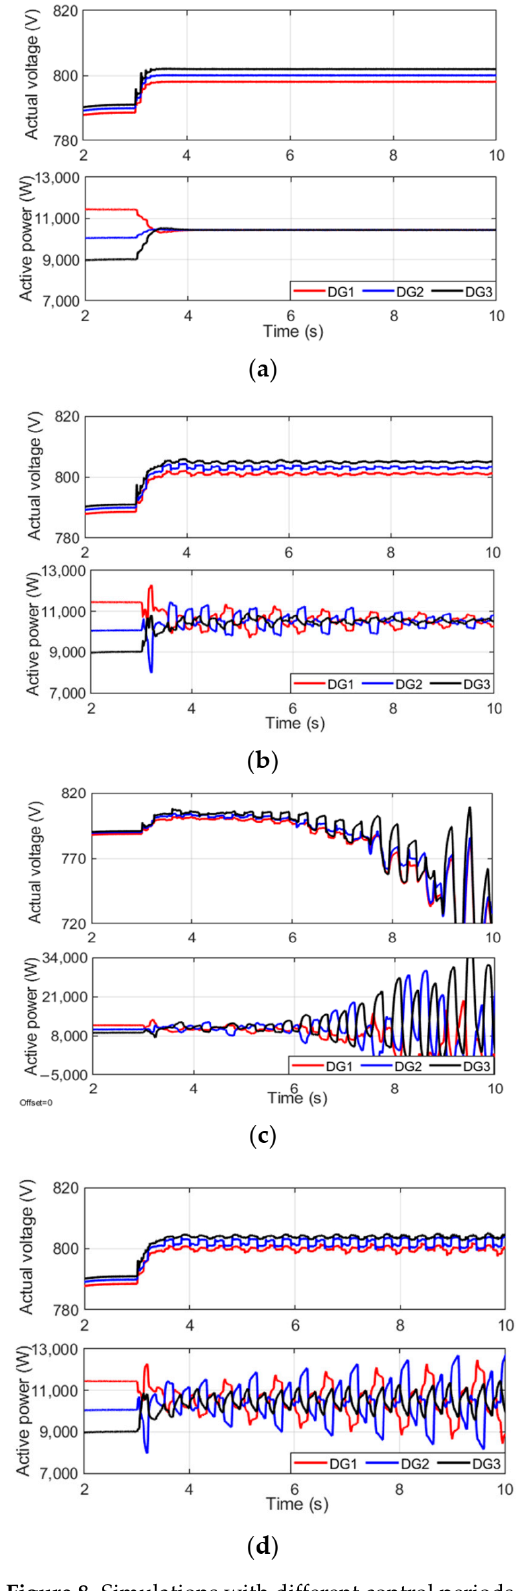
Figure 8. Simulations with different control periods. ( a ) T 1 , T 2 , T 3 = 0.1 s. ( b ) T 1 = 0.12 s, T 2 = 0.16 s, T 3 = 0.07 s. ( c ) T 1 = 0.12 s, T 2 = 0.16 s, T 3 = 0.18 s. ( d ) T 1 = 0.12 s, T 2 = 0.16 s, T 3 = 0.04